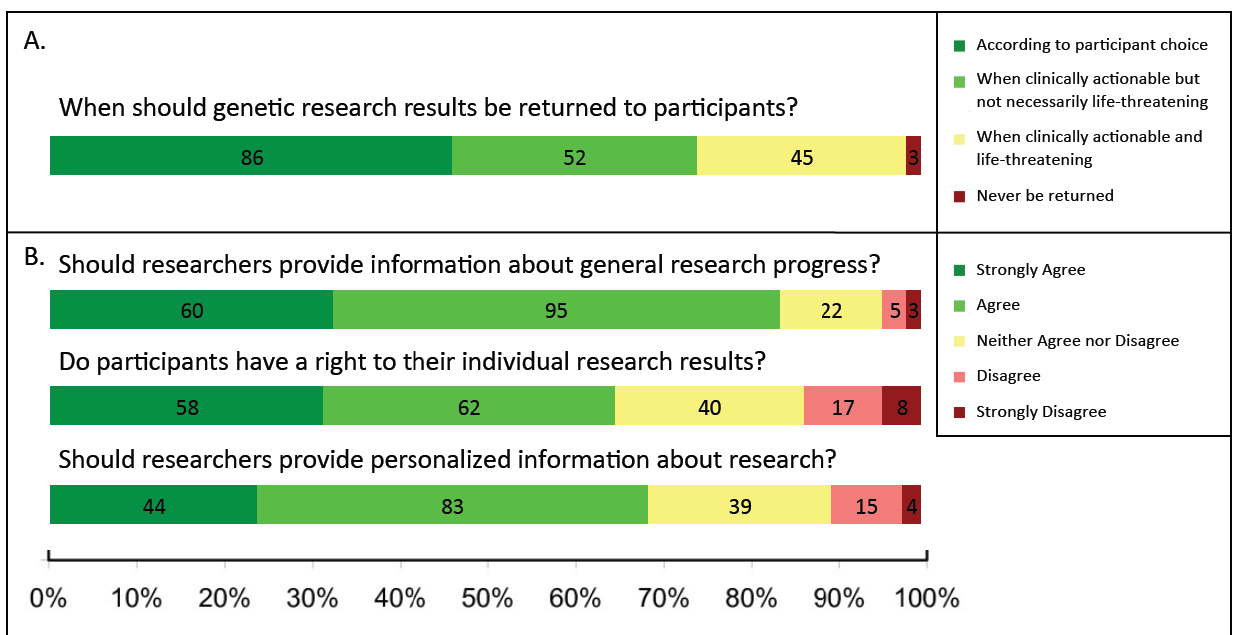
Figure 3. Attitudes towards return of research results to participants among researchers